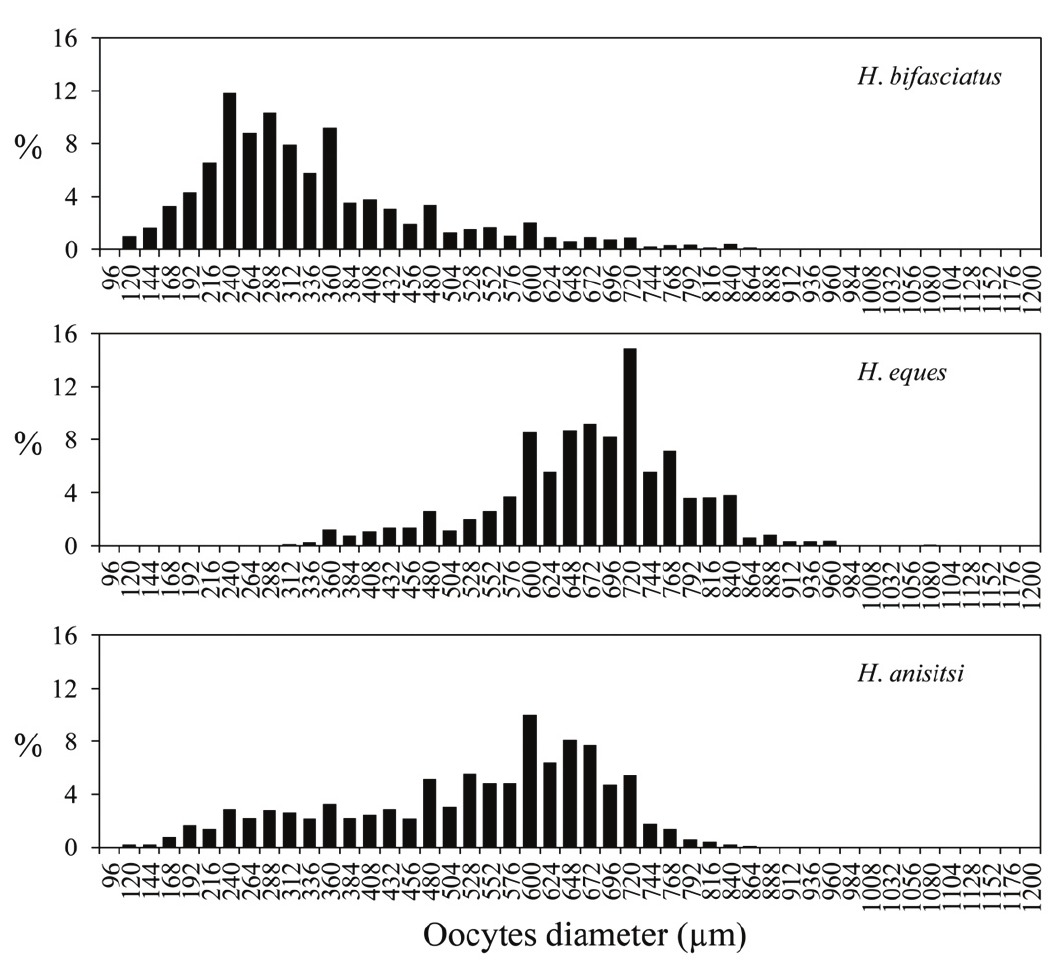
Figure 1. Frequency (%) of oocytes by diameters classes of Hyphessobrycon species, showing one oocytes batch to H . bifasciatus and H . eques , and two oocytes batches to H . anisitsi